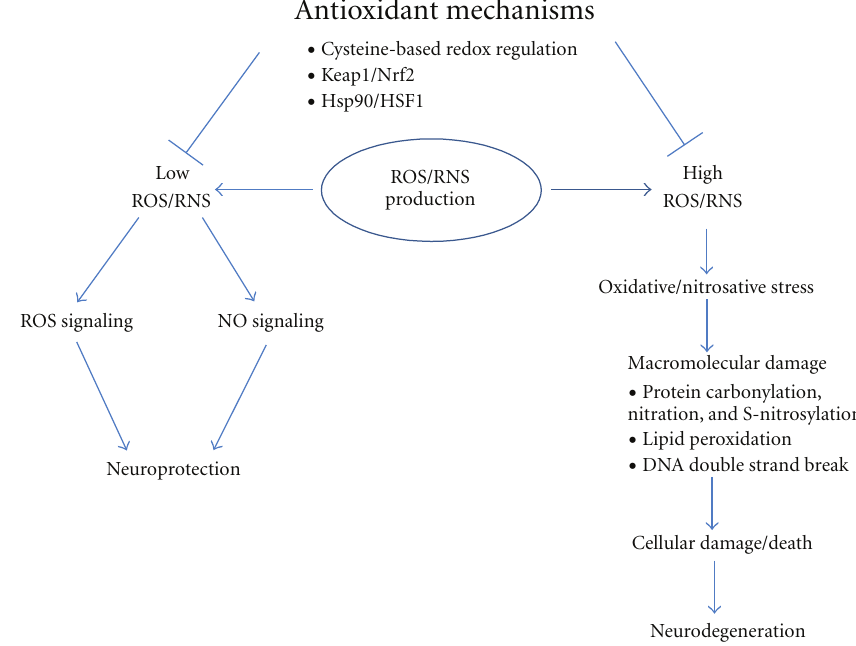
Figure 1: Imbalance in oxidant production and antioxidant mechanisms contributes to neurodegeneration. Under physiological conditions, antioxidant mechanisms such as cysteine-based redox regulation (Prx, Grx, Trx, glutathione (GSH), etc.), as well as transcriptional pathways represented by Keap1/Nrf2 and Hsp90/HSF1, maintain low concentrations of ROS/RNS in the neurons. These low levels of oxidants activate specific signaling pathways that subserve normal cell signaling and in fact may be neuroprotective in nature. On the other hand, under pathological situations, including AD and PD, there is a decrease in antioxidant mechanisms and increased oxidant production, e ff ectively creating high levels of ROS/RNS. Oxidative/nitrosative stress generated in this manner can contribute to cell damage and results in